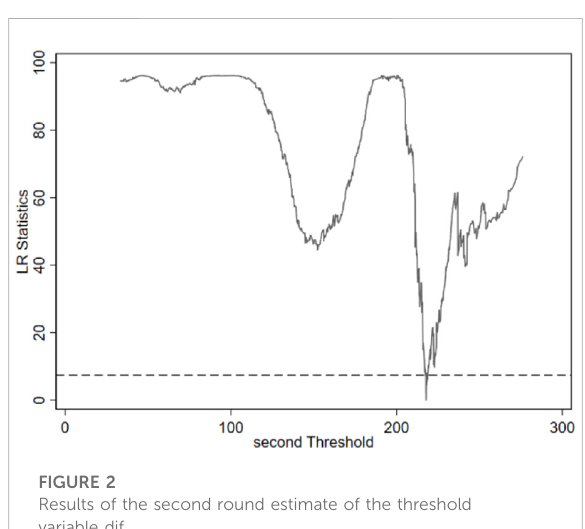
FIGURE 1 Results of the fi rst round estimate of the threshold variable dif.